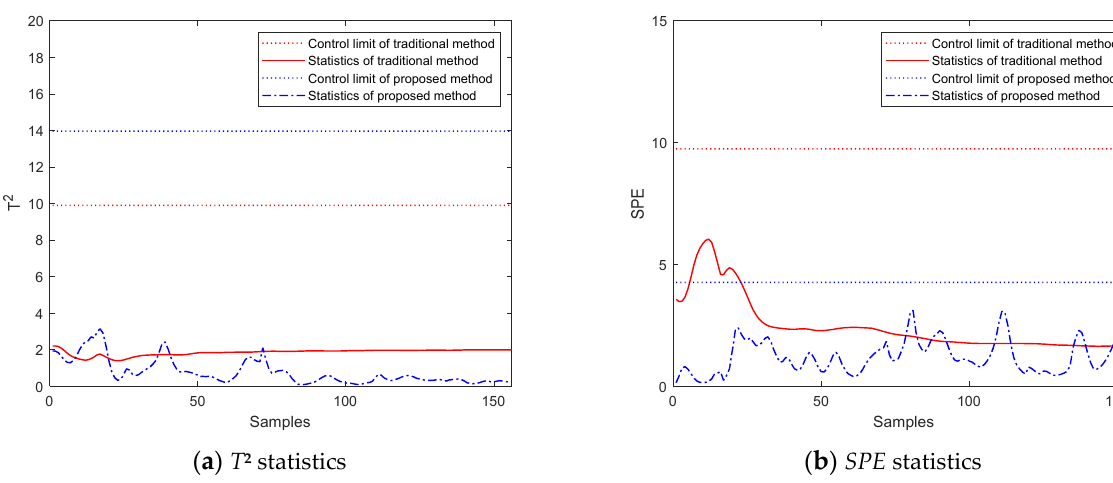
Figure 5. Online monitoring of the injection phase.